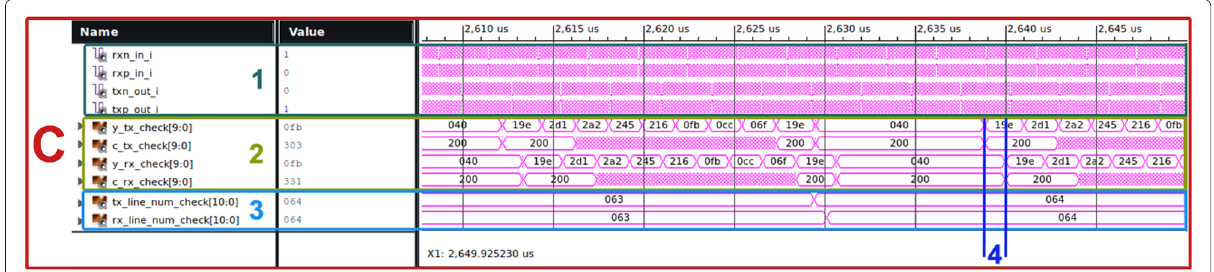
Fig. 10 The simulation screenshot shows a complete chain experiment with bar generator